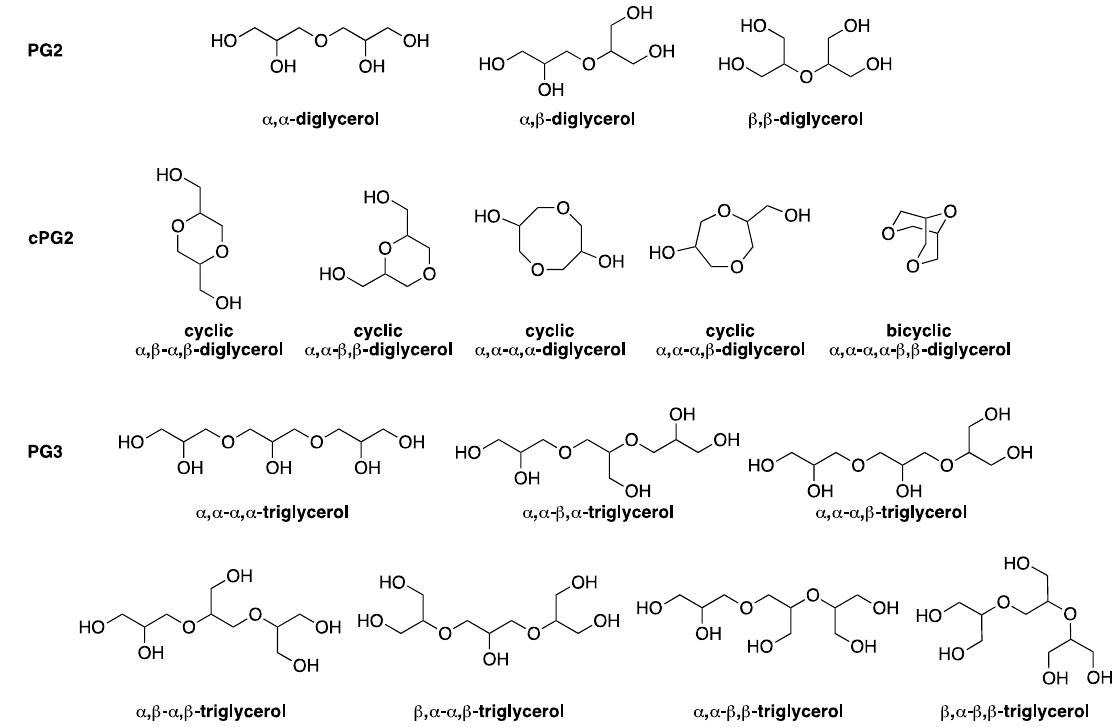
Figure 3. Linear/branched isomers of diglycerol (PG2) and triglycerol (PG3) and cyclic isomers of diglycerol (cPG2).